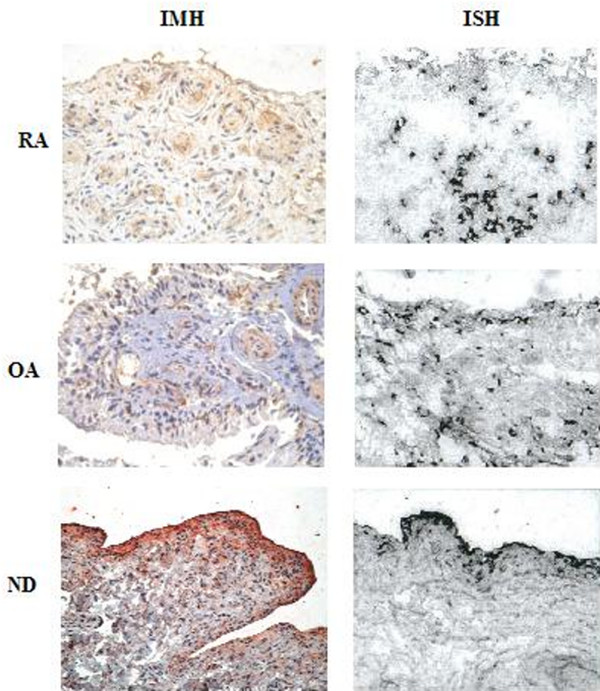
Immunohistochemistry (IMH) and in situ hybridization (ISH) of synovial tissues for BMP-5. Histomorphological distribution of BMP-5 is comparable to that of BMP-4 (Figure 4). Original magnifications: immunohistochemistry (IMH): rheumatoid arthritis (RA), osteoarthritis (OA), normal donors (ND) ×20; in situ hybridization (ISH): RA, OA, ND ×40. BMP, bone morphogenetic protein.